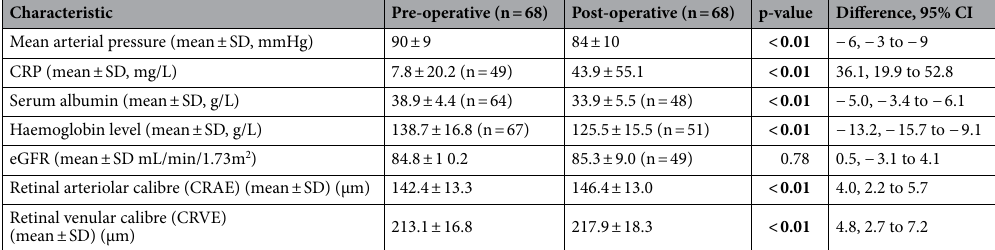
Table 2. Pre- and post-operative biomarker and vessel calibre changes. Significant values are in bold.